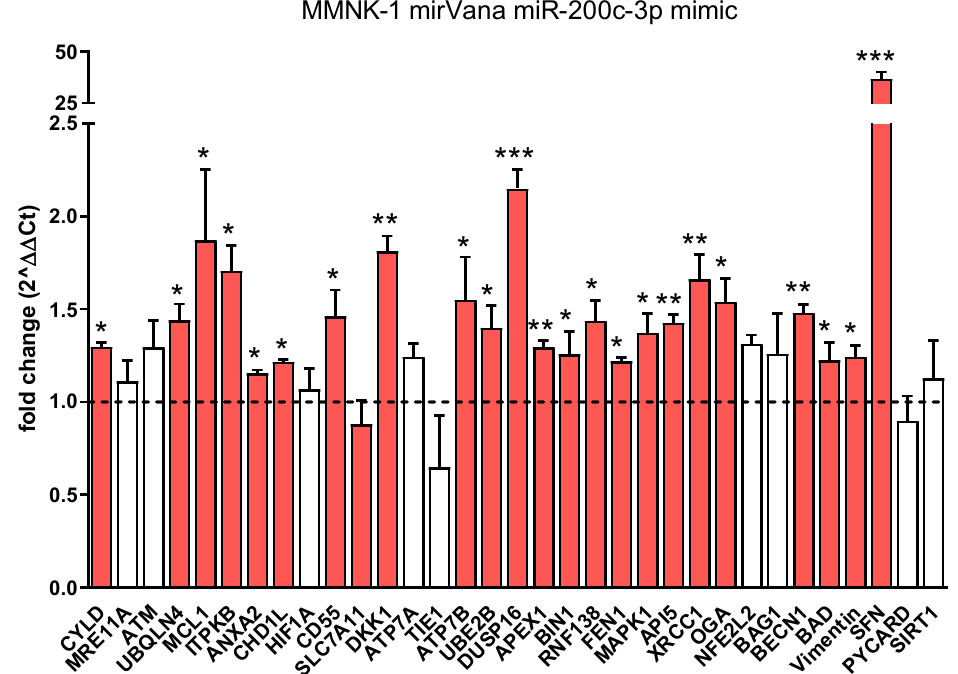
Figure 6. The cisplatin conferring genes DUSP16 and SFN are significantly (>2 fold, p -value < 0.05) up-regulated in miR-200c-3p overexpressing cells. MMNK-1 cells were transfected with 10 nM mirVana miR-200c-3p mimic or 10 nM mirVana miRNA mimic Negative Control. After 48 h, total RNA was isolated from 70 to 90% confluent cells using QIAzol Lysis Reagent. Reverse Transcription Quantitative PCR (RT-qPCR) of cisplatin-resistance-conferring genes was performed, and gene expression was normalized to GAPDH and U6. Differences in gene expression were evaluated by the ∆∆ Ct method. Unpaired two-tailed t-test was used to evaluate statistical significance. * p < 0.05, ** p < 0.01, *** p <